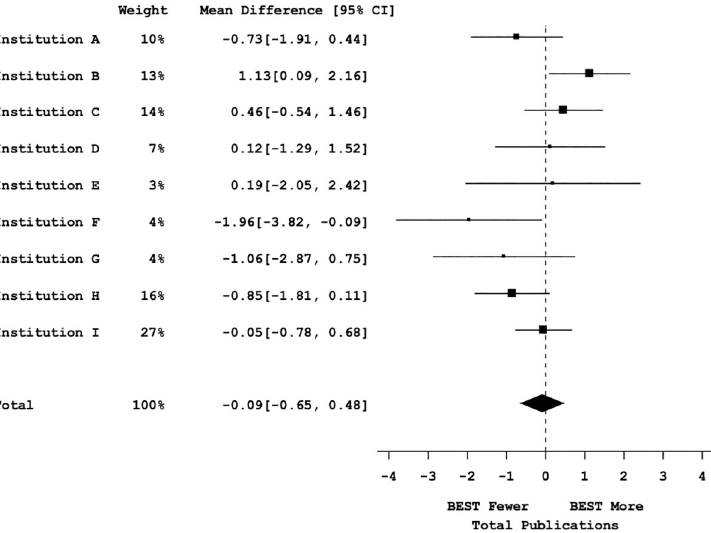
Fig 5. Graduate student productivity measured by total publications vs. bivariate participation. Mega-analysis forest plot displaying mean effect sizes (squares) and confidence intervals (brackets) for effect sizes of total publications vs. bivariate professional development participation (control vs. participants). Large squares denote greater impact on the summary effect based on sample size and effect size in each institutional sample. The vertical dotted line represents a null effect. The size and shape of the diamond at the bottom of the forest plot represent the effect size. Because the diamond overlaps the vertical line (null effect), this indicates that the effect of professional development participation on total publication is not significant. See Table J in S1 Text for statistical results. All data sets are available at https:// osf.io/qy3pa/ (permanent DOI: 10.17605/OSF.IO/QY3PA; see also [33]). BEST, Broadening Experiences in Scientific